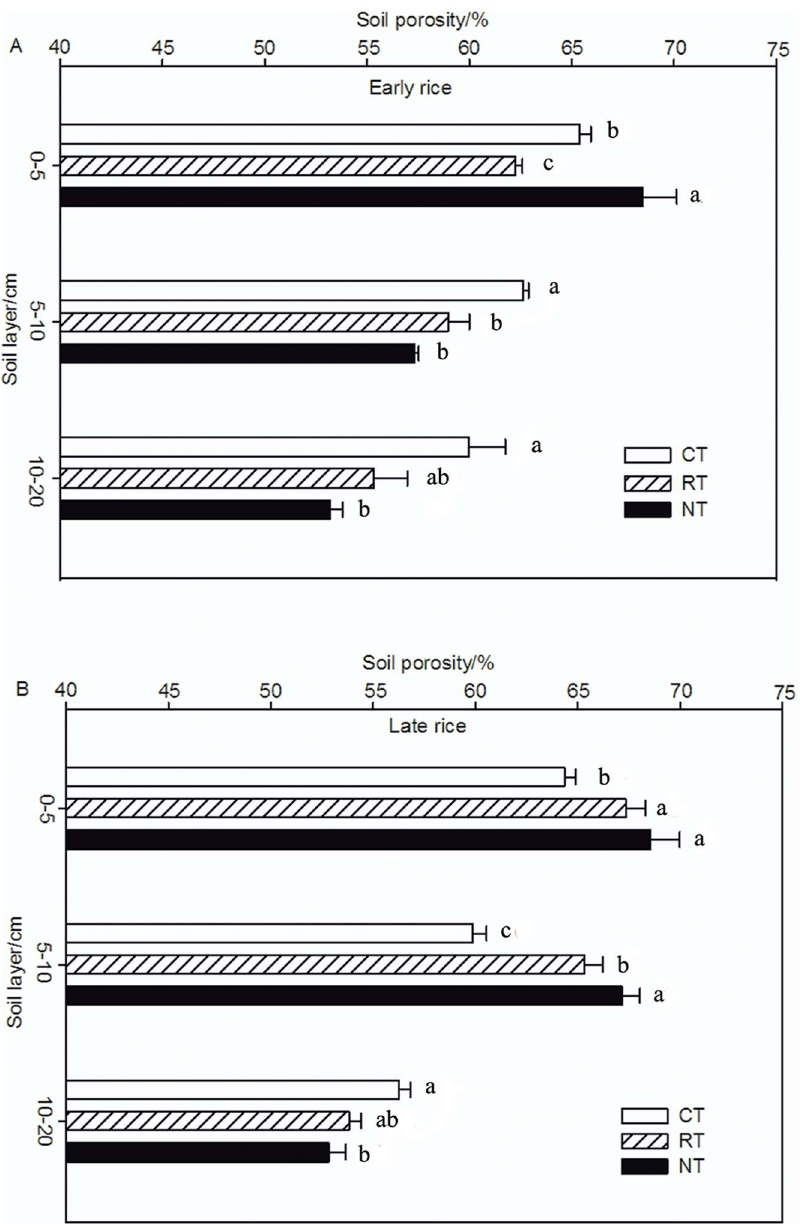
Figure 2. Soil porosity of different tillage treatments in 2008 (A for the early rice season and B for the late rice season). Data are means of three replications; means followed by different letters are significantly different at P , 0.05 .